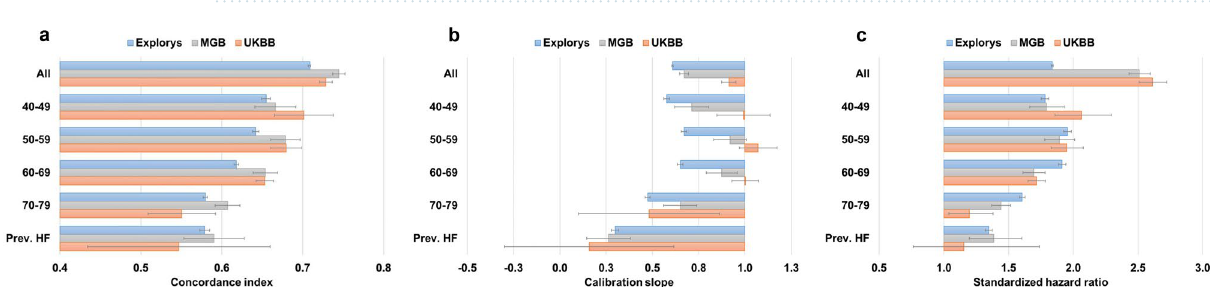
Figure 3. Fairness analysis for CHARGE-AF. Note that data was not available in the UKBB for the 75–84 and 85–90 age subpopulations.